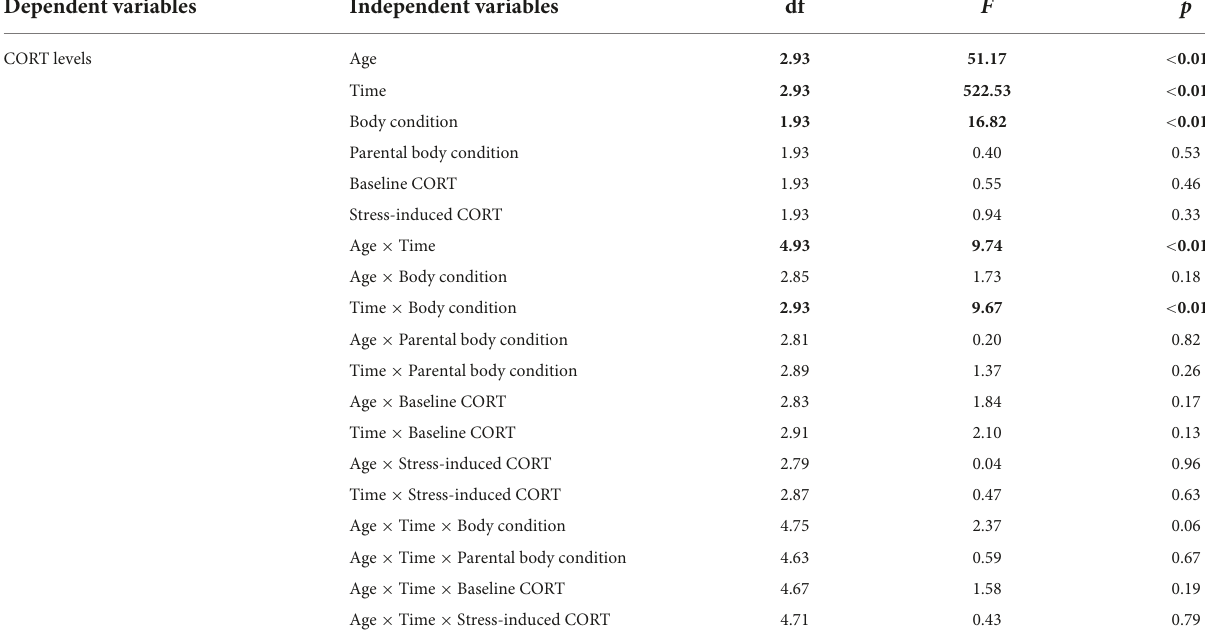
TABLE 2 Model selections to test the influence of the age of the chick (11-, 20-, and 37-days old), body condition of the chick, baseline and stress-induced corticosterone levels of the parent (“baseline CORT” and “stress-induced CORT”), body condition of the parent (“parental body condition”), and all interactions on corticosterone